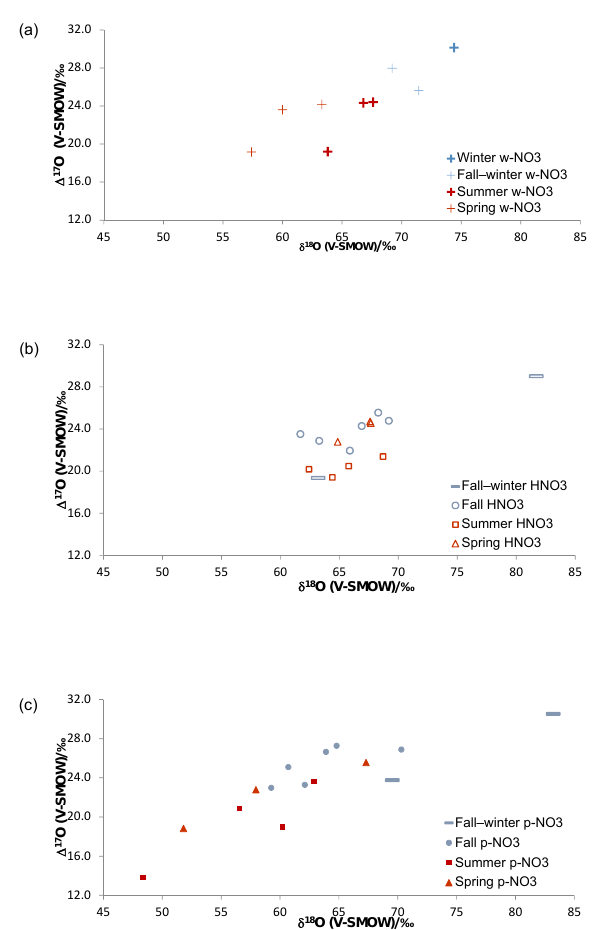
Figure 2. Triple O isotopic results obtained for simultaneously col- lected atmospheric HNO 3 (a) , w NO − berta, identified by sampling periods (cold months – blue; warm months –